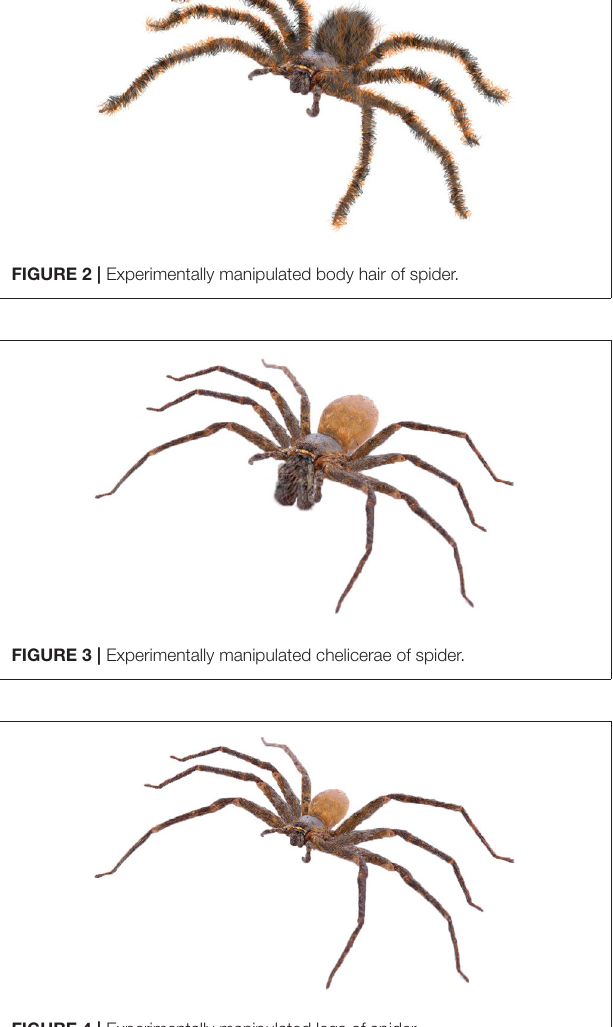
characteristic (legs, eyes, chelicerae, abdomen, and hairs). The poll of spider pictures includes one original and five modified images, which were paired in 15 possible dyads.